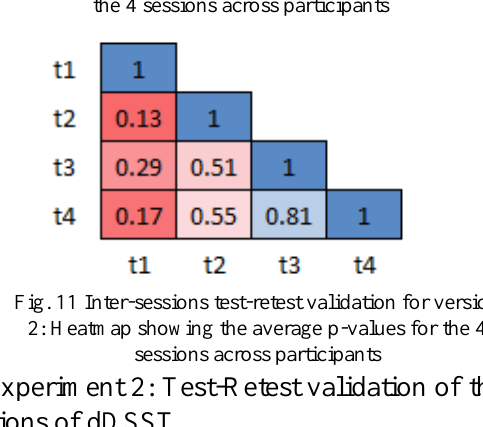
Fig. 10 Inter-sessions test-retest validation for ver- sion 2: Heatmap showing the average p-values for the 4 sessions across participants